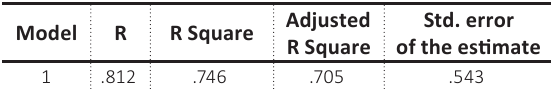
Table 4. Model summary